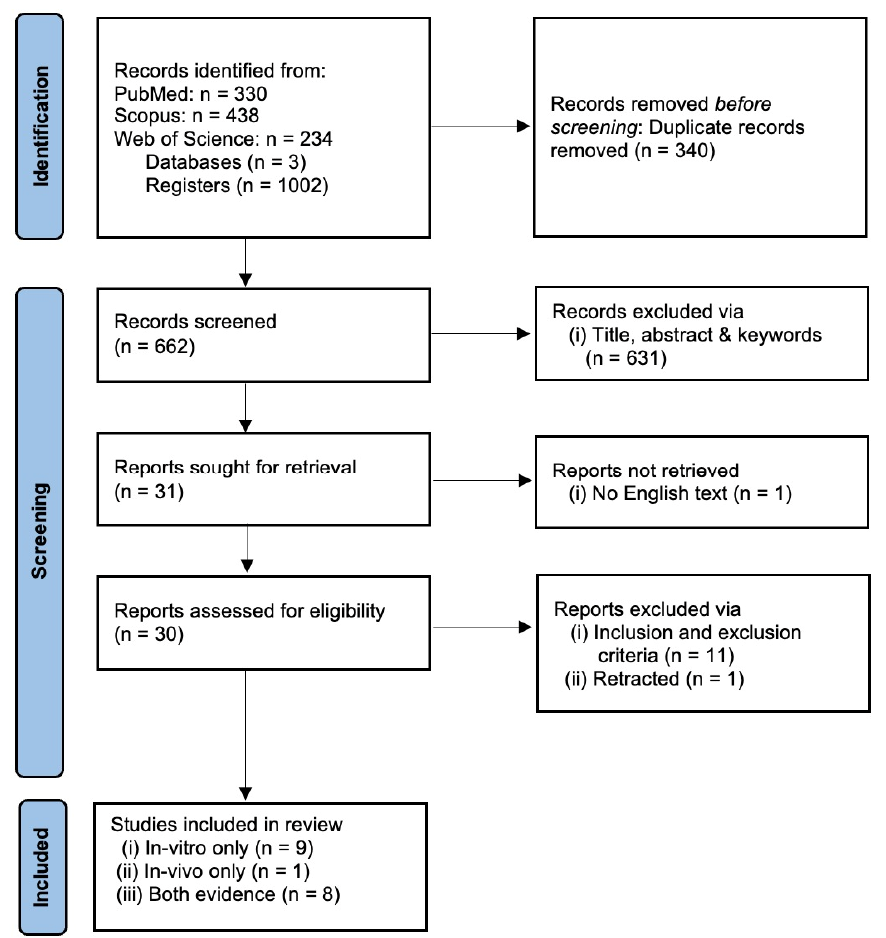
Figure 1. PRISMA flow chart for systematic review.